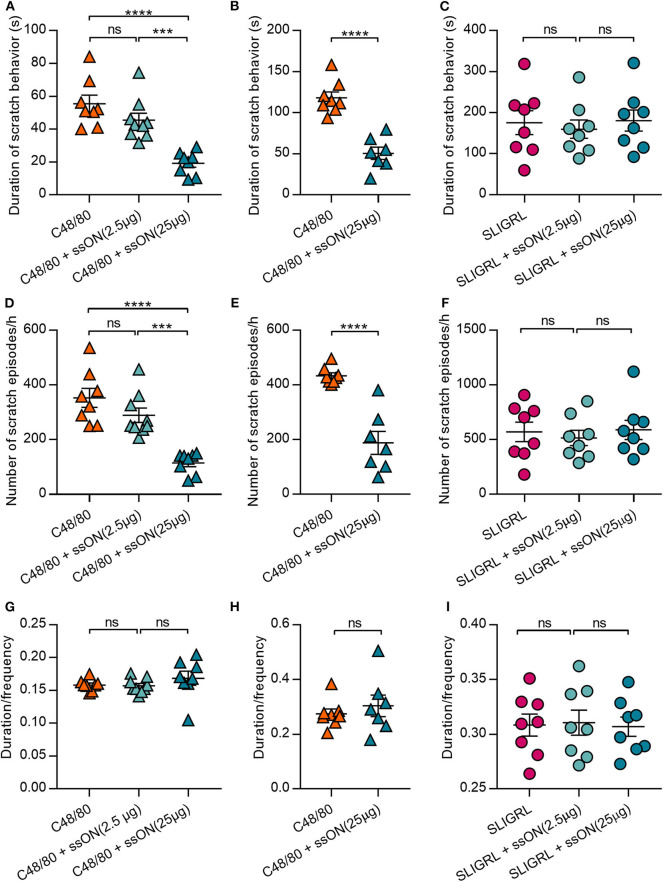
C48/80-induced scratch behavior was inhibited by ssON in a concentration dependent manner, while PAR2-mediated scratch behavior was unaffected. (A–C) Duration of scratch behavior (seconds), (D–F) frequency of scratch behaviors, and (G–I) the mean length per scratch behavior (duration/frequency) were recorded for 1 h immediately following treatment in two separately performed experiments (A,C,D,F,G,I and B,E,H, respectively). Histamine-related scratch behavior was induced by intradermal injection of 50 μL of either C48/80 (10 μg) alone or a combination of C48/80 (10 μg) and ssON (25 μg or 2.5 μg). Non-histamine-related scratch behavior was induced by intradermal injection of 50 μL of either SLIGRL (100 μg) alone or a combination of SLIGRL (100 μg) and ssON (2.5 or 25 μg). Statistical significance was assessed by one-way ANOVA or unpaired, two-tailed t-test for (B, E,H). All data passed Shapiro-Wilk's normality test (GraphPad Prism); N = 7–9 mice. P-value: ****P < 0.0001, ***P = 0.0002–0.0005, ns, non-significant. Data is shown as mean ± SEM.